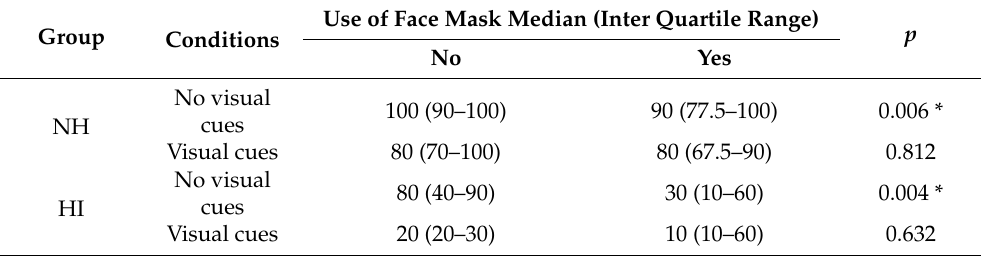
Table 2. Statistical analysis of the groups’ speech performance in the mask and no mask conditions (* p <